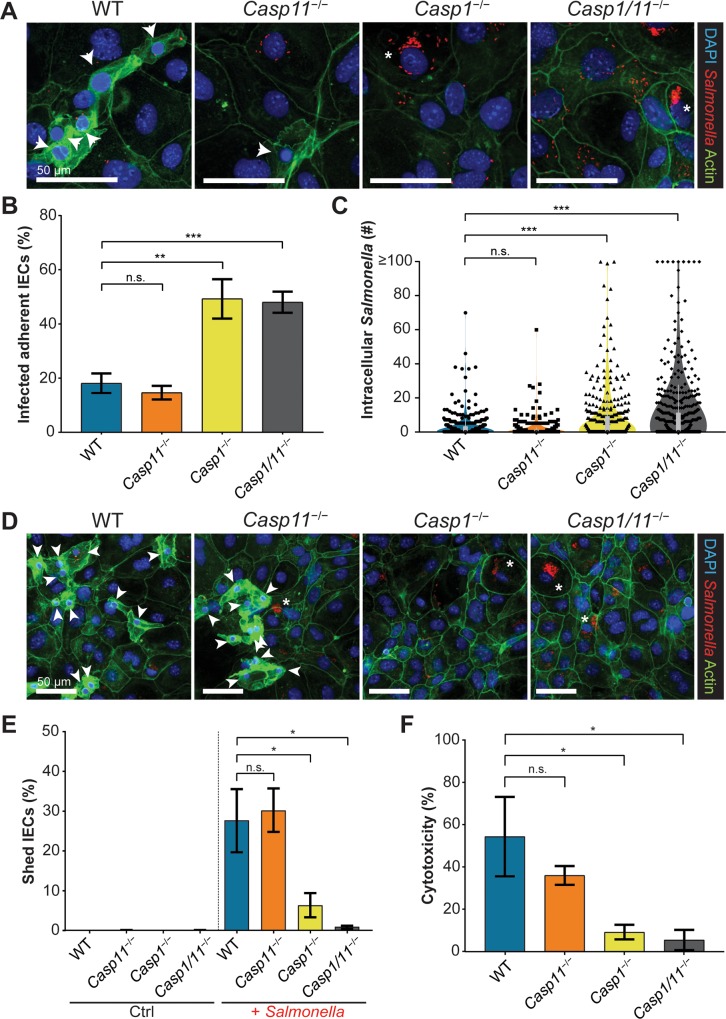
Epithelial intrinsic inflammasomes restrict the intracellular proliferation of Salmonella predominantly through caspase-1 induced cell shedding and death.Cecal enteroid monolayers derived from WT, Casp11−/−, Casp1−/− and Casp1/11−/− mice were infected with mCherry-S. Typhimurium (MOI of 50) and bacterial colonization was assessed at 10 h p.i. by fluorescence microscopy. Representative fluorescence images depicting Salmonella (red), actin (green) and DNA (blue) (A). Original magnification ×400; scale bars 50μm. Arrows denote actively shedding or shed IECs and asterisks denote large foci of intracellular Salmonella. The severity of infection was also determined by the percentage of adherent infected IECs (B) and the number of intracellular Salmonella in each infected IEC (C). Results are from at least 400 IECs from two independent experiments. Representative fluorescence images of Salmonella-induced cell shedding; Salmonella (red), actin (green) and DNA (blue) (D). Original magnification ×200; scale bars 50μm. Percentage of shed/shedding IECs from the monolayer (from at least four blinded fields of view from two independent experiments) (E). IEC cytotoxicity as measured by lactate dehydrogenase activity released into the growth media at 10 h p.i. (F). Mean and SEM indicated from duplicate wells in two independent experiments. Statistical significance for 2B-C and 2E calculated using Mann-Whitney U-test and student t-test applied to 2F (n.s. p>0.05; *p<0.05; **p<0.01; ***p<0.001).